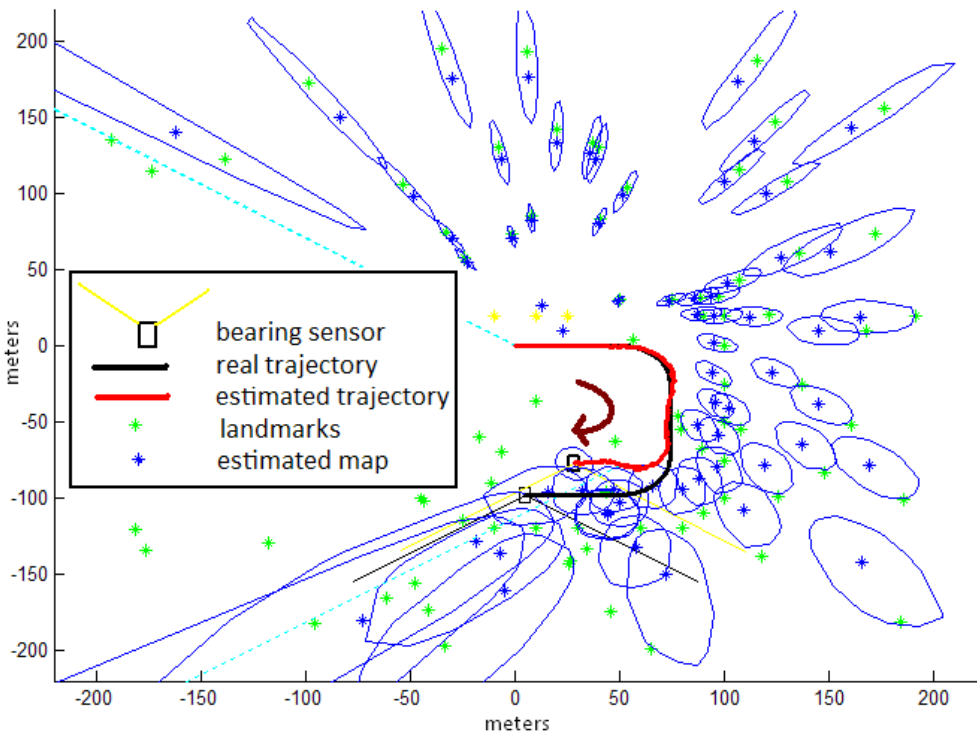
Figure 8. SLAM simulation using the concurrent initialization